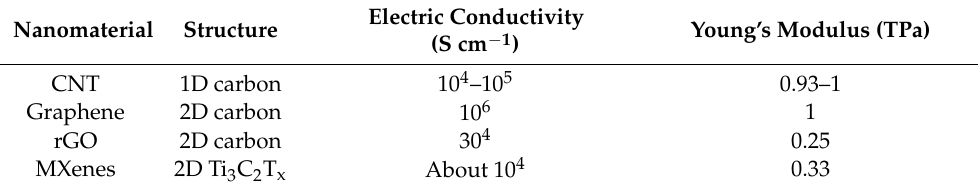
Table 1. Properties of conductive 1D and 2D nanomaterials